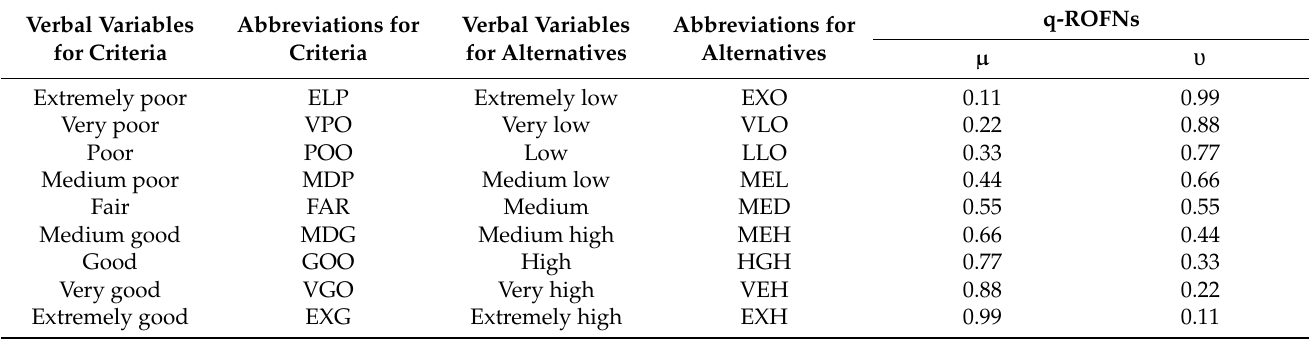
Table 1. Verbal variables and their corresponding q-ROFNs for the weighting criteria and ranking alternatives.